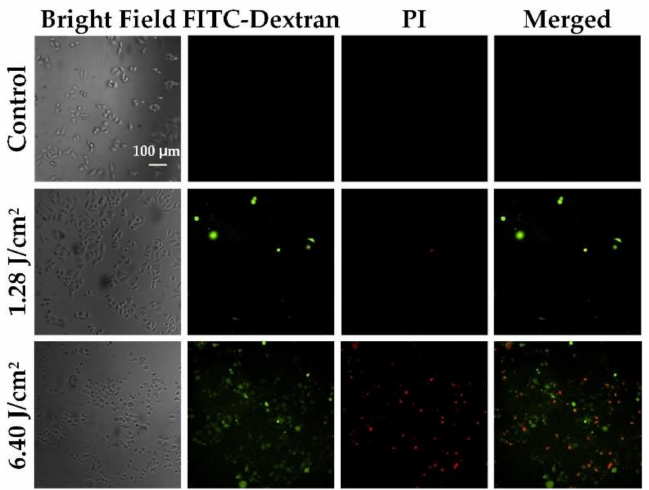
Figure 5. Fluorescence images of the intracellular delivery of FD10 for HeLa cells after treatment with different laser fluences.